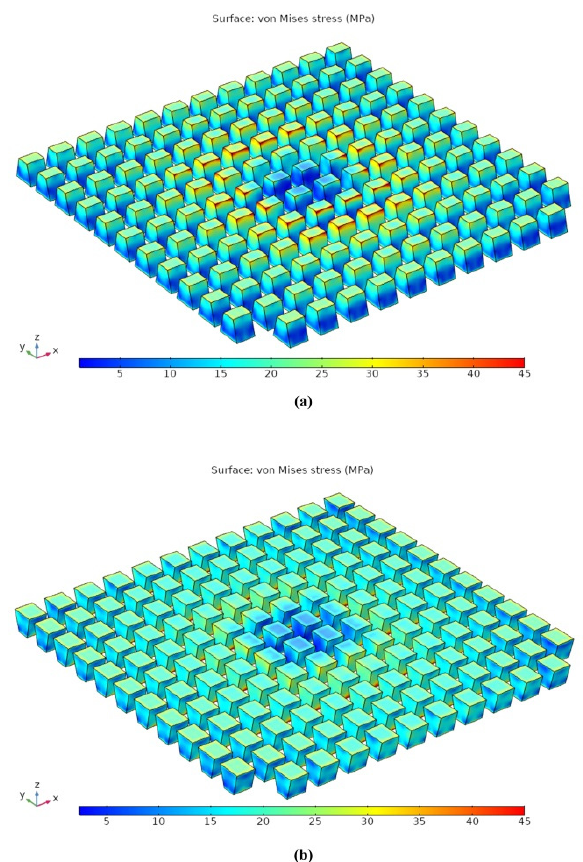
Figure 10. The von Mises stress nephogram of full-scale trapezoidal-shaped thermoelectric legs when H = 1.6 mm, I = 4 A ( a ) R A = 0.56 and ( b ) R A = 1.8.